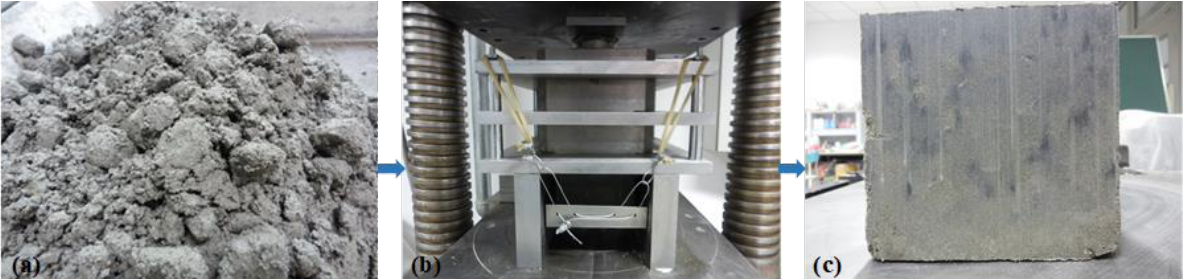
Figure 6. The process of an artificial rockfill prepared by pressure forming method: ( a ) concrete mixing; ( b ) loading; ( c ) curing.